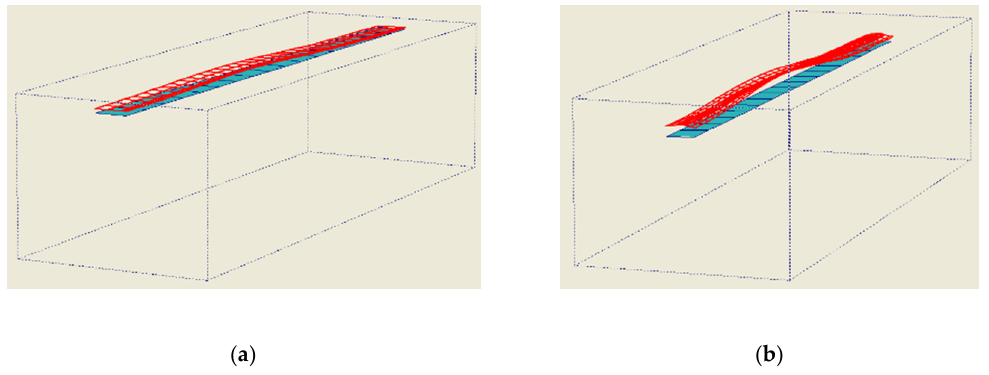
Figure 15. Soft soil ground surface displacements, ( a ) with foundation and ( b ) without foundation.